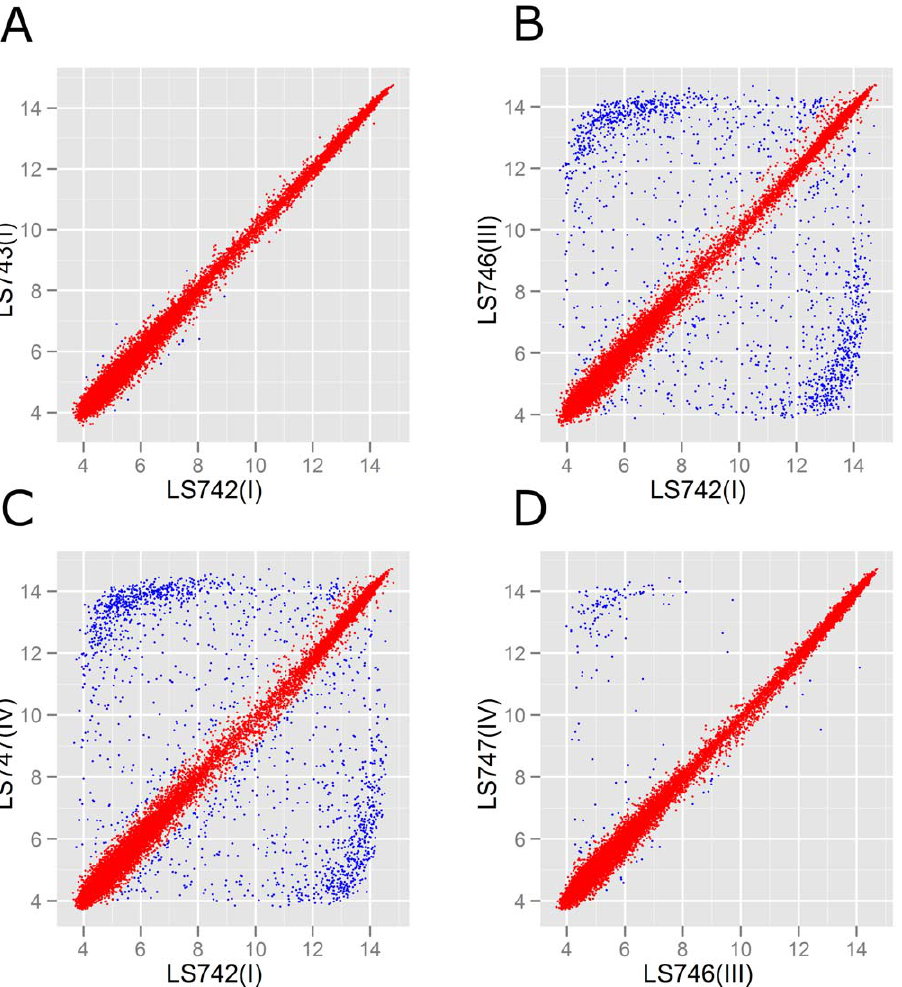
Figure 7. Comparison of the RMA summarized probe-set intensities. (A) pattern combination I isolates - LS742 and LS743; (B) pattern combination I (LS742) and pattern combination III (LS746); (C) pattern combination I (LS742) and pattern combination IV (LS747); (D) pattern combination III (LS746) and pattern combination IV(LS747). Red dots indicate RMA summarized probe-set intensity differences of less than or equal to 2-fold between two strains. Blue dots indicate RMA summarized probe-set intensity differences of more than 2-fold between the two strains.